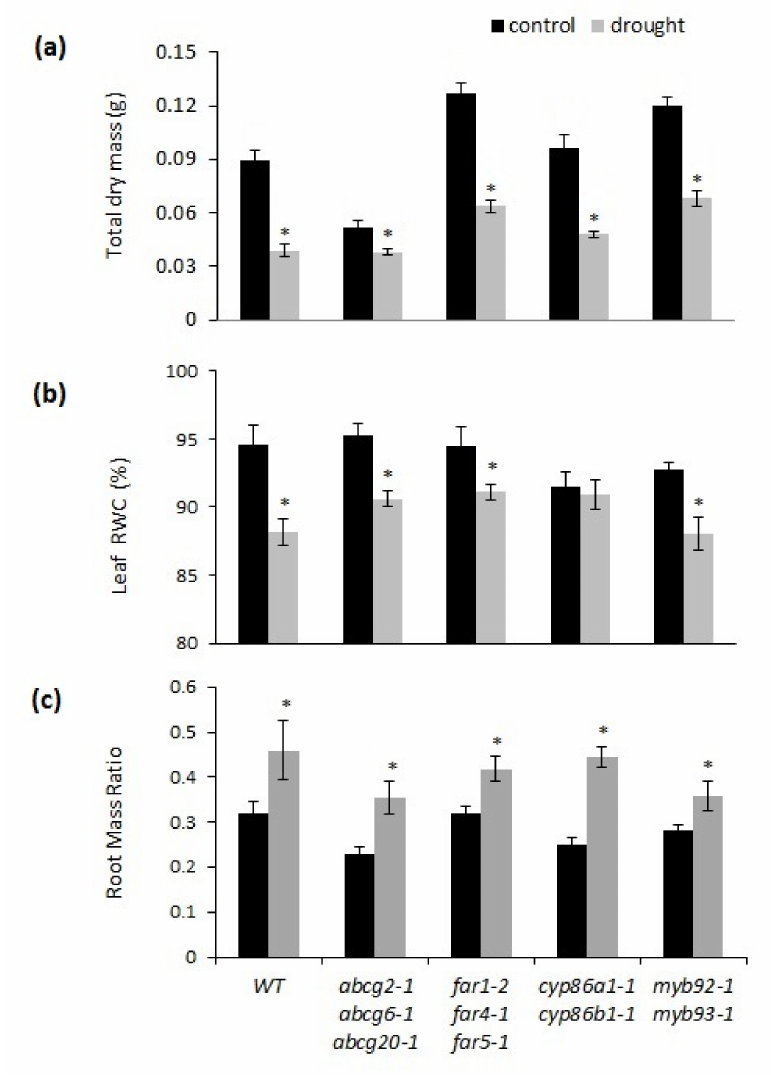
Figure 3. Comparison of drought stress responses between wild-type and suberin mutants. ( a ) Total plant dry mass, ( b ) leaf relative water content (RWC), ( c ) root mass ratio (ratio between root dry mass and total dry mass). Mean values from ten replicate plants ± SE. ANOVA results indicated significant genotype and treatment interactions for total plant dry mass at p < 0.01, and for RWC at p < 0.05 (Table S1). Asterisks indicate significant differences by Student’s t -test at p < 0.05 comparing control and